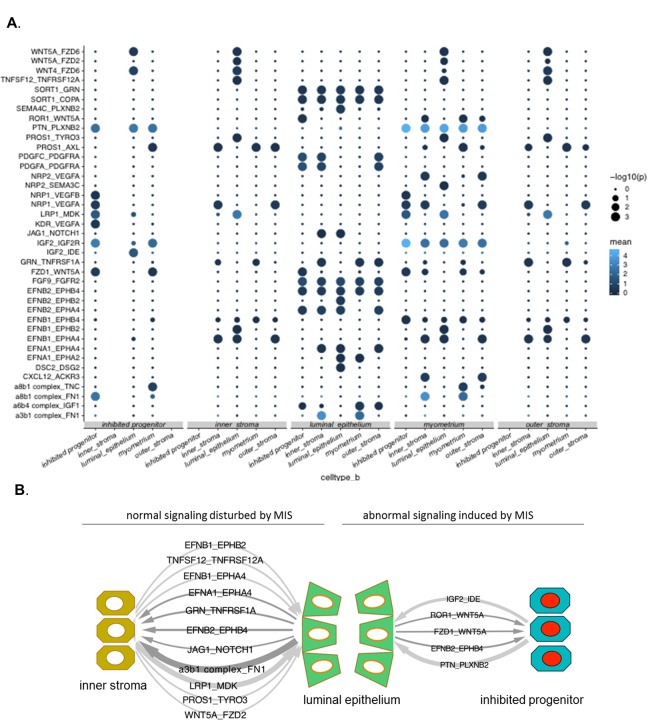
Receptor-ligand interactions in the control and MIS-treated uterine atlases.(A) Overview of ligand–receptor interactions in the PDN6 rat uteri was generated using scRNAseq data, which was extrapolated to protein-protein interactions using the CellPhoneDB algorithm. P-values indicated by circle size (see legend on right) and average gene expression values are indicated by blue color (see legend on right) (Figure 4—source data 1).